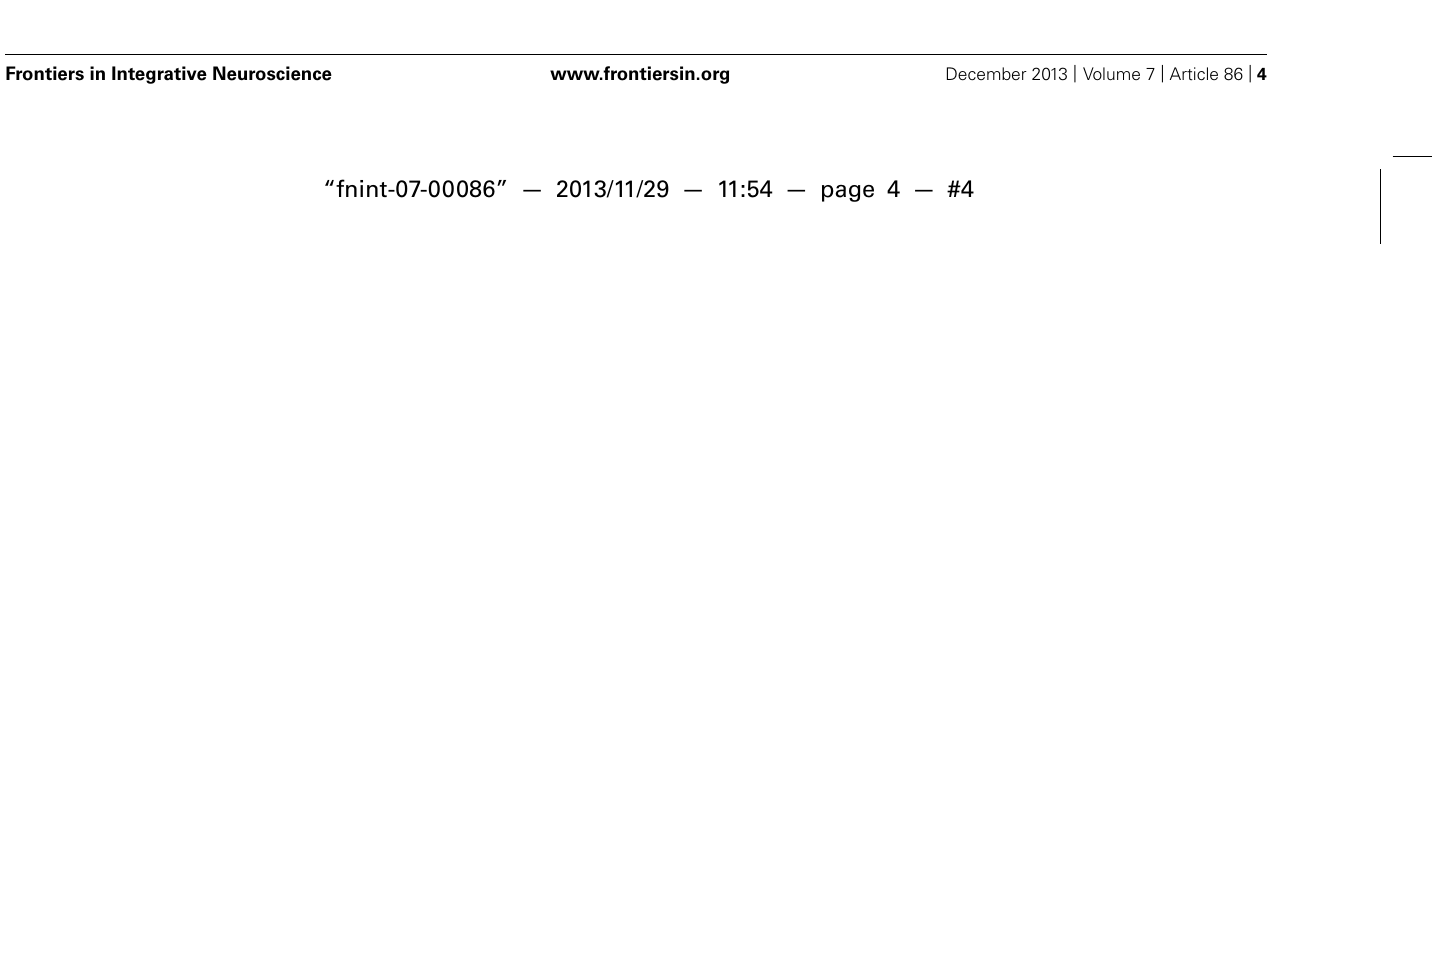
nervous system is connected to the CNS via sympathetic and parasympathetic pathways, forming the brain-gut axis (BGA). Four levels for the control of BGA are shown (Wood etal., 1999).The stress response of the BGA influences the generation of dIgA and/or the pIgR mediated trancytosis. NTs, neurotransmitters; NPs, neuropeptides; GCs,